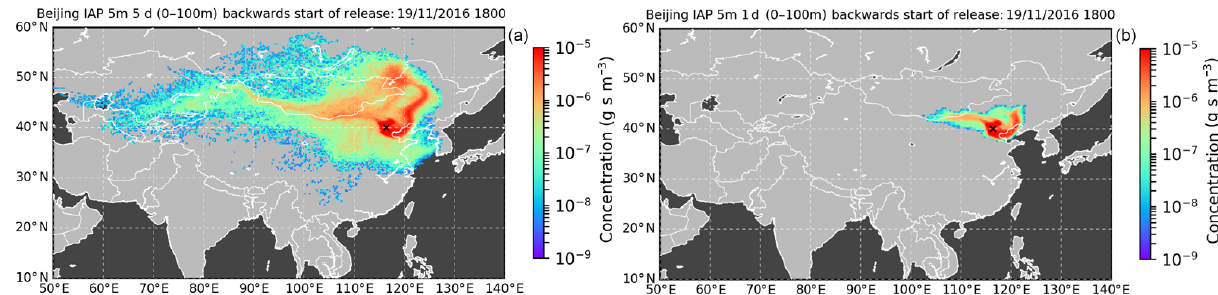
Figure 1. Five-day backwards NAME footprint arriving at IAP meteorological tower (a) and 1d backwards NAME footprint arriving at IAP meteorological tower (b) .